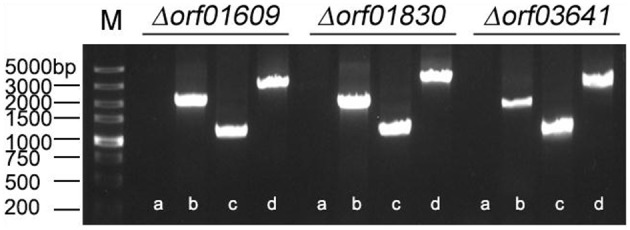
Confirmation of the knockout mutant strains Δorf01609, Δorf01830, and Δorf03641. M: DL5000 marker; a: The fragment of genomic deletion mutant DNA amplified using cloning primers. b: The fragment of genomic wild-type (LP-2) DNA amplified using cloning primers. c: The fragment of genomic deletion mutant DNA amplified using the primer pair P7/P8. d: The fragment of genomic wild-type (LP-2) DNA amplified using the primer pair P7/P8.